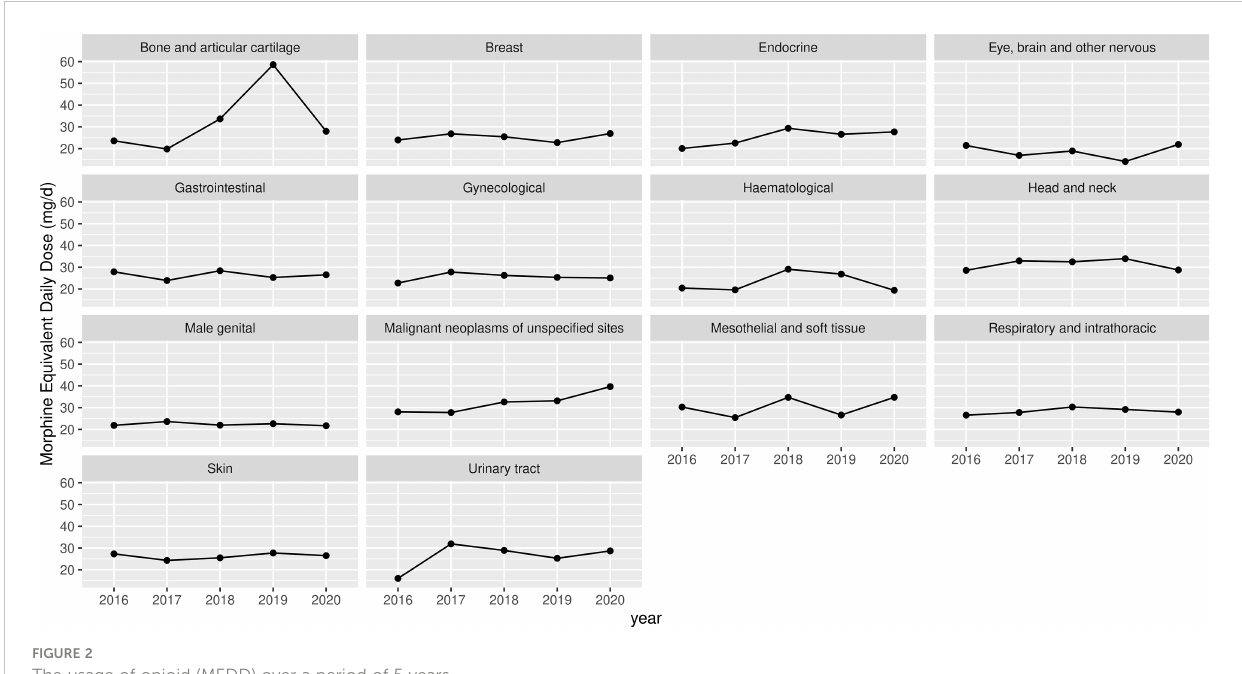
FIGURE 2 The usage of opioid (MEDD) over a period of 5 years.